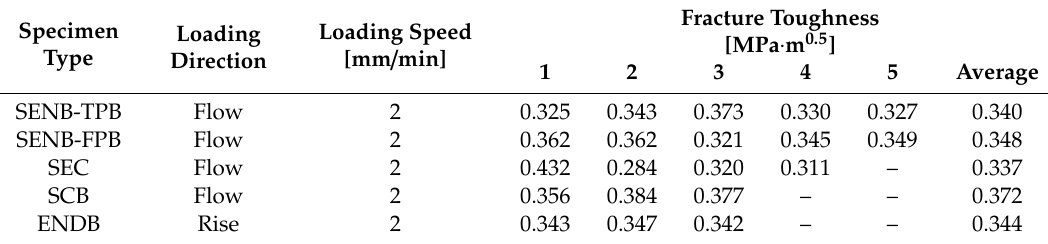
Table 4. Fracture toughness results for 300 kg / m 3 PUR foam